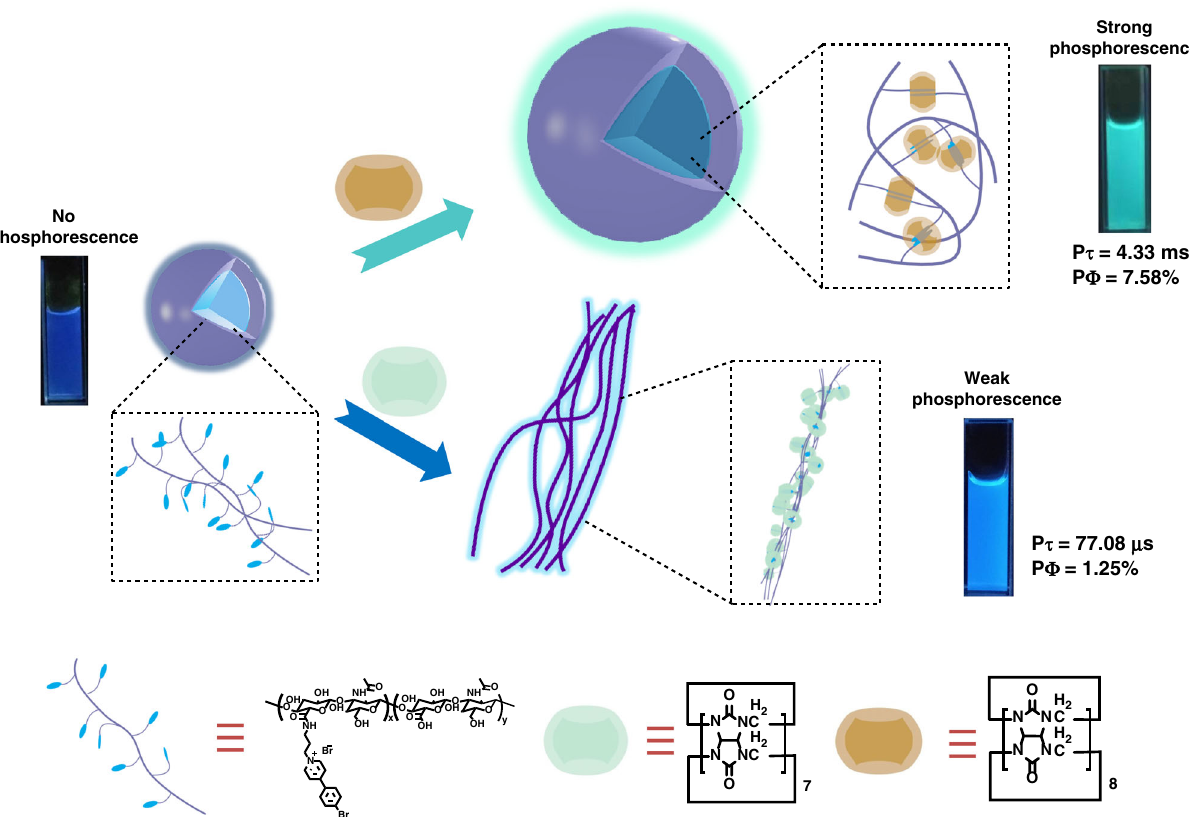
Fig. 1 Schematic illustration. The construction and behavior of CBs/HA – BrBP supramolecular pseudorotaxane polymers in aqueous